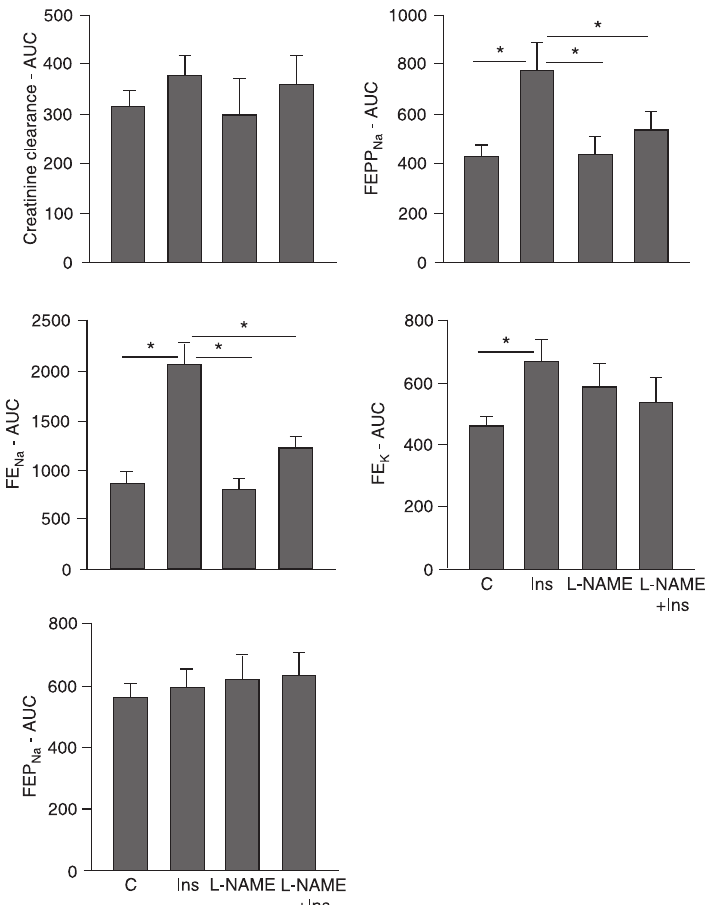
Figure 2. Effect of lateral intracerebroventricular microinjection of 126 ng/3 µL insulin (Ins) on creatinine clearance, fractional excretion of sodium (FE Na ), proximal (FEP Na ) and post-proximal (FEPP Na ) fractional excretion of sodium and fractional excretion of potassium (FE K ) compared to icv administration of 0.15 M NaCl (C), 126 ng/3 µL insulin + 60 µg L-NAME (Ins + L-NAME) and 60 µg L-NAME in Wistar-Hannover rats. Data are reported as means ± SEM. AUC = area under the curve. *P ≤ 0.05 as indicated by the horizontal lines (ANOVA and Bonferroni’s contrast test).